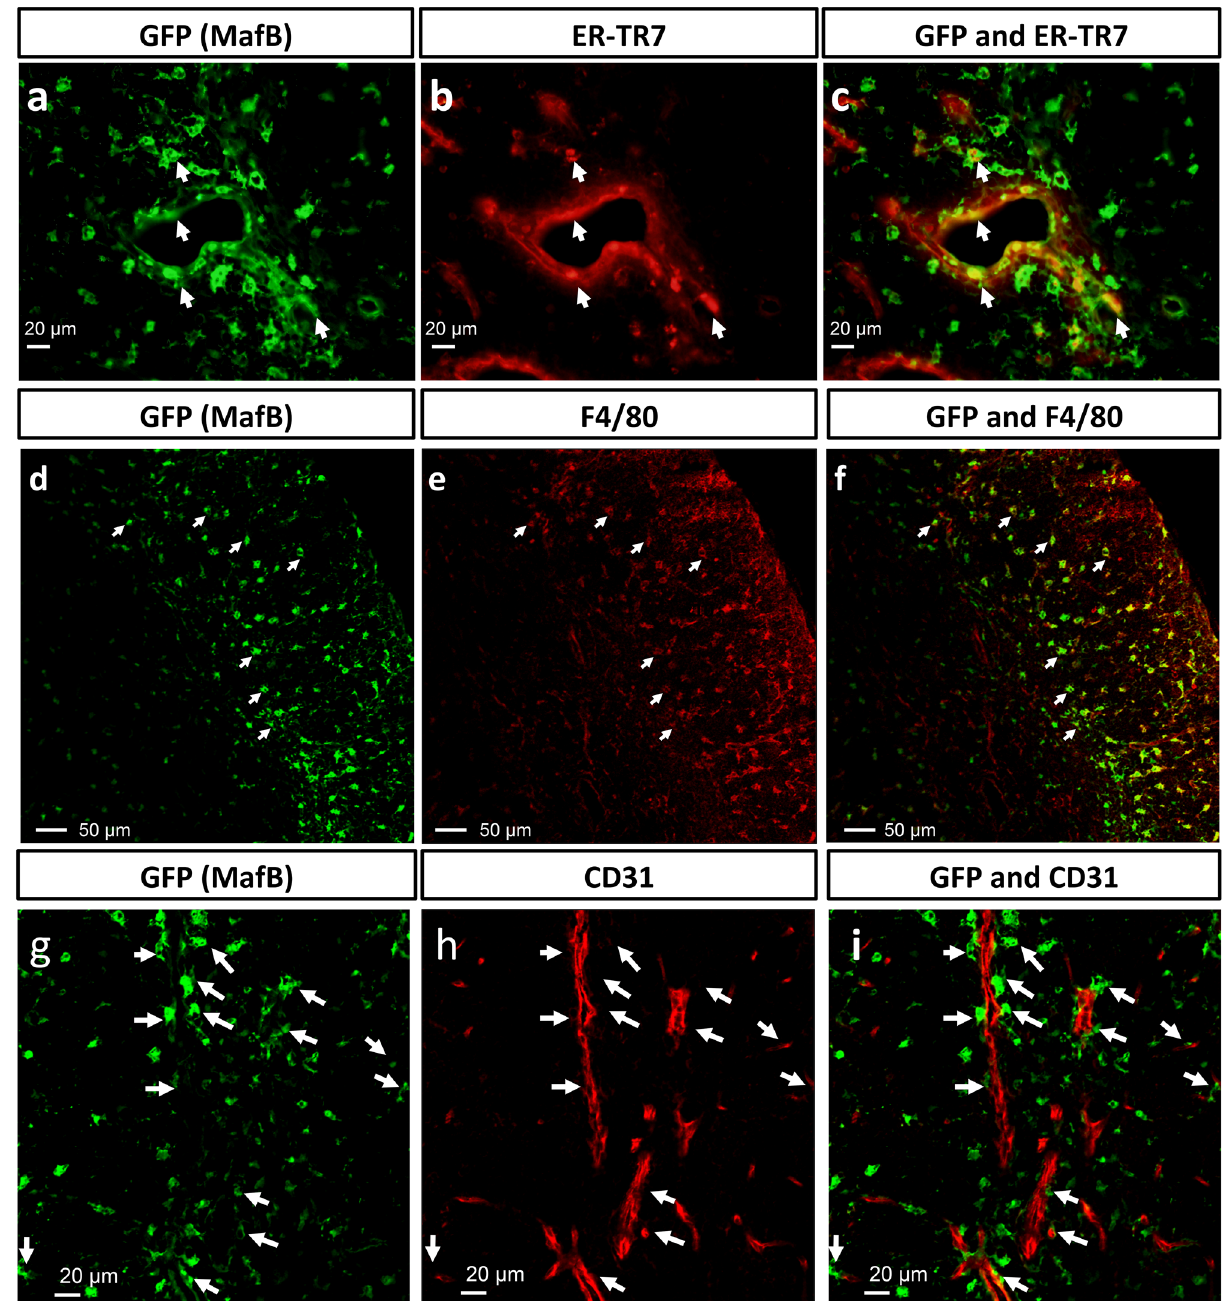
Figure 2. MafB-expressing cells in the adult thymus were predominantly F4/80 + macrophages/monocytes and ER-TR7 + perivascular fibroblasts. ( a , b ) GFP expression (green color, representing MafB-expressing cells) and ER-TR7 expression (red color, representing fibroblasts) were shown by immunofluorescence staining of MafB + /GFP thymus frozen sections (transverse). ( c ) White arrows indicate co-localization of GFP and ER-TR7 expression. Scale bar: 20 µm. ( d – e ) GFP expression (green color, MafB-expressing cells) and F4/80 expression (red color, representing macrophages/monocytes) were demonstrated by immunofluorescence staining of MafB + /GFP thymus frozen sections (transverse). ( f ) White arrows indicate co-localization of GFP and F4/80 expression. Scale bar: 50 µm. ( g – h ) GFP expression (green color, representing MafB-expressing cells) and CD31 expression (red color, representing vascular endothelium) shown by immunofluorescence staining of MafB + /GFP thymus frozen sections (transverse). ( i ) White arrows indicate the localization of GFP positive cells adjacent to endothelial cells. Scale bar: 20 μm. All data shown are representative results of 3 independent experiments using adult specimens from different litters (n =